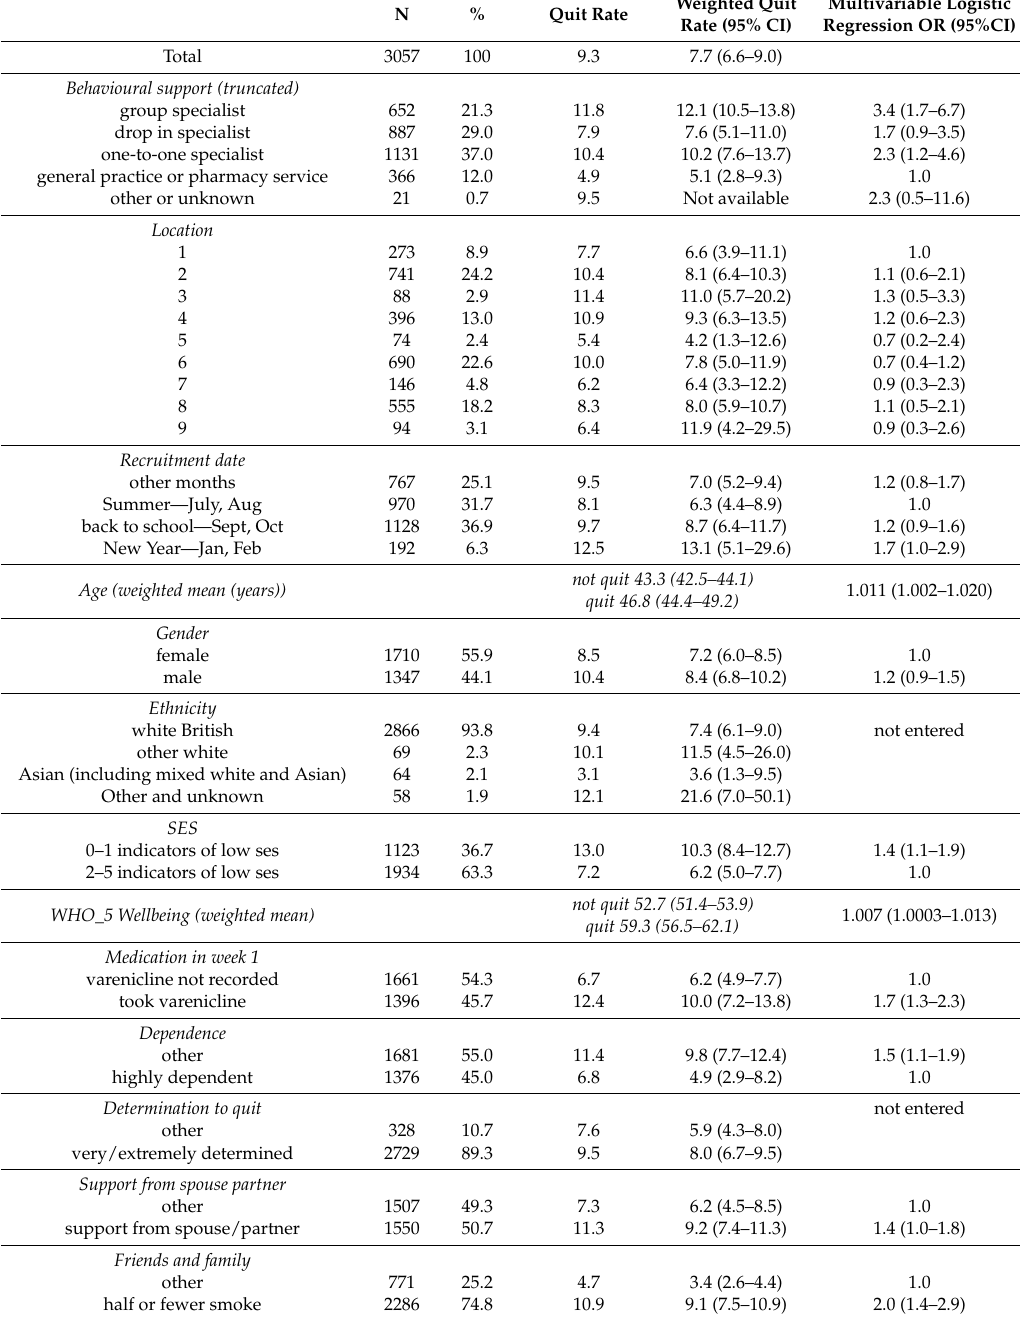
Table 2. ELONS 52-week raw and weighted CO validated quit rates at 52 weeks (percents and 95% confidence interval (CI)), weighted mean age and wellbeing (and weighted 95% CI) and adjusted odds ratios from multivariable logistic regression model of CO validated